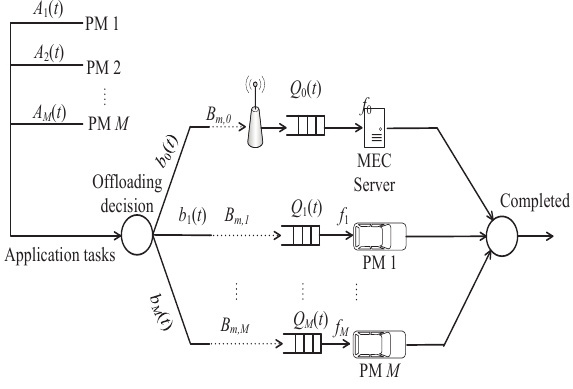
Figure 3. Task offloading queue